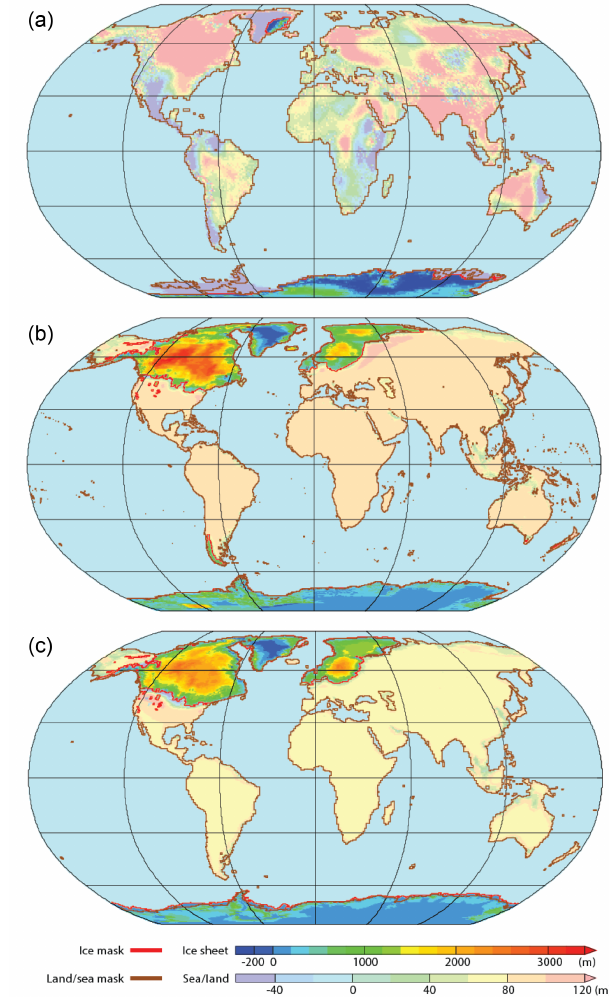
Figure 2. Changes in boundary conditions related to changes in ice sheets for the midPliocene-eoi400 (a) and lgm ( b : ICE-6G_C and c : GLAC-1D) experiments. Coastlines for the palaeo-period shown as brown contours. Ice sheet boundaries for each period shown as red contours. Bright shading: changes in altitude over regions covered by ice sheets during the considered palaeo-period. Faded shading: changes in altitude over ice-free